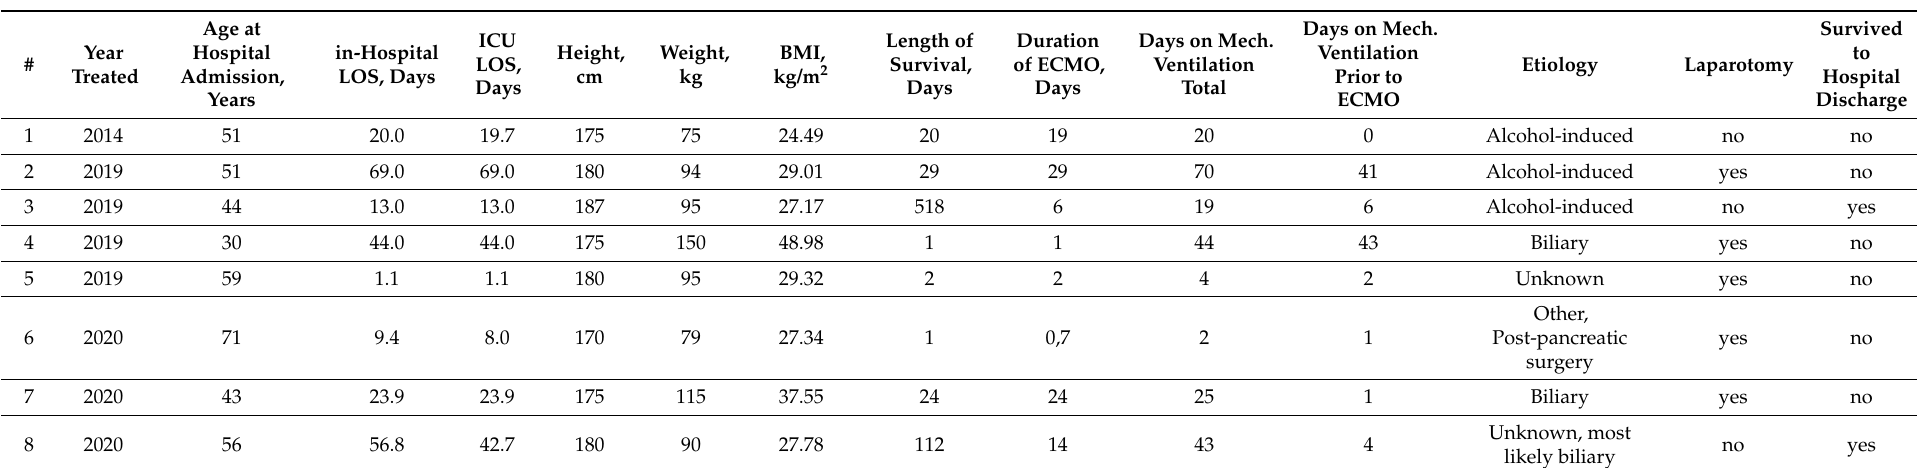
Table 1. Patient